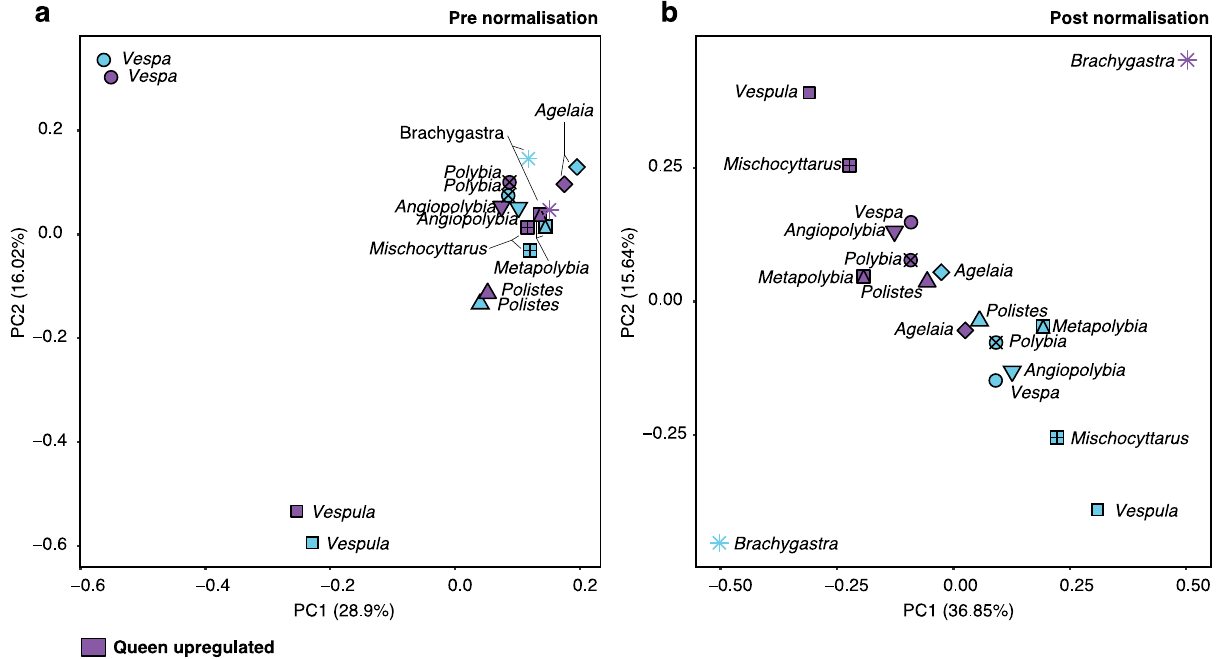
haveexpressionbelow10countspermillion. b Principalcomponentanalysisofthe species-normalisedandscaledTPMgeneexpressionvaluesusingsame fi ltersas( a ). Caste denoted by purple (queen) or blue (worker). Each species has a different shape/symbol. The percent of variation explained by the fi rst two principal com- ponents is listed in